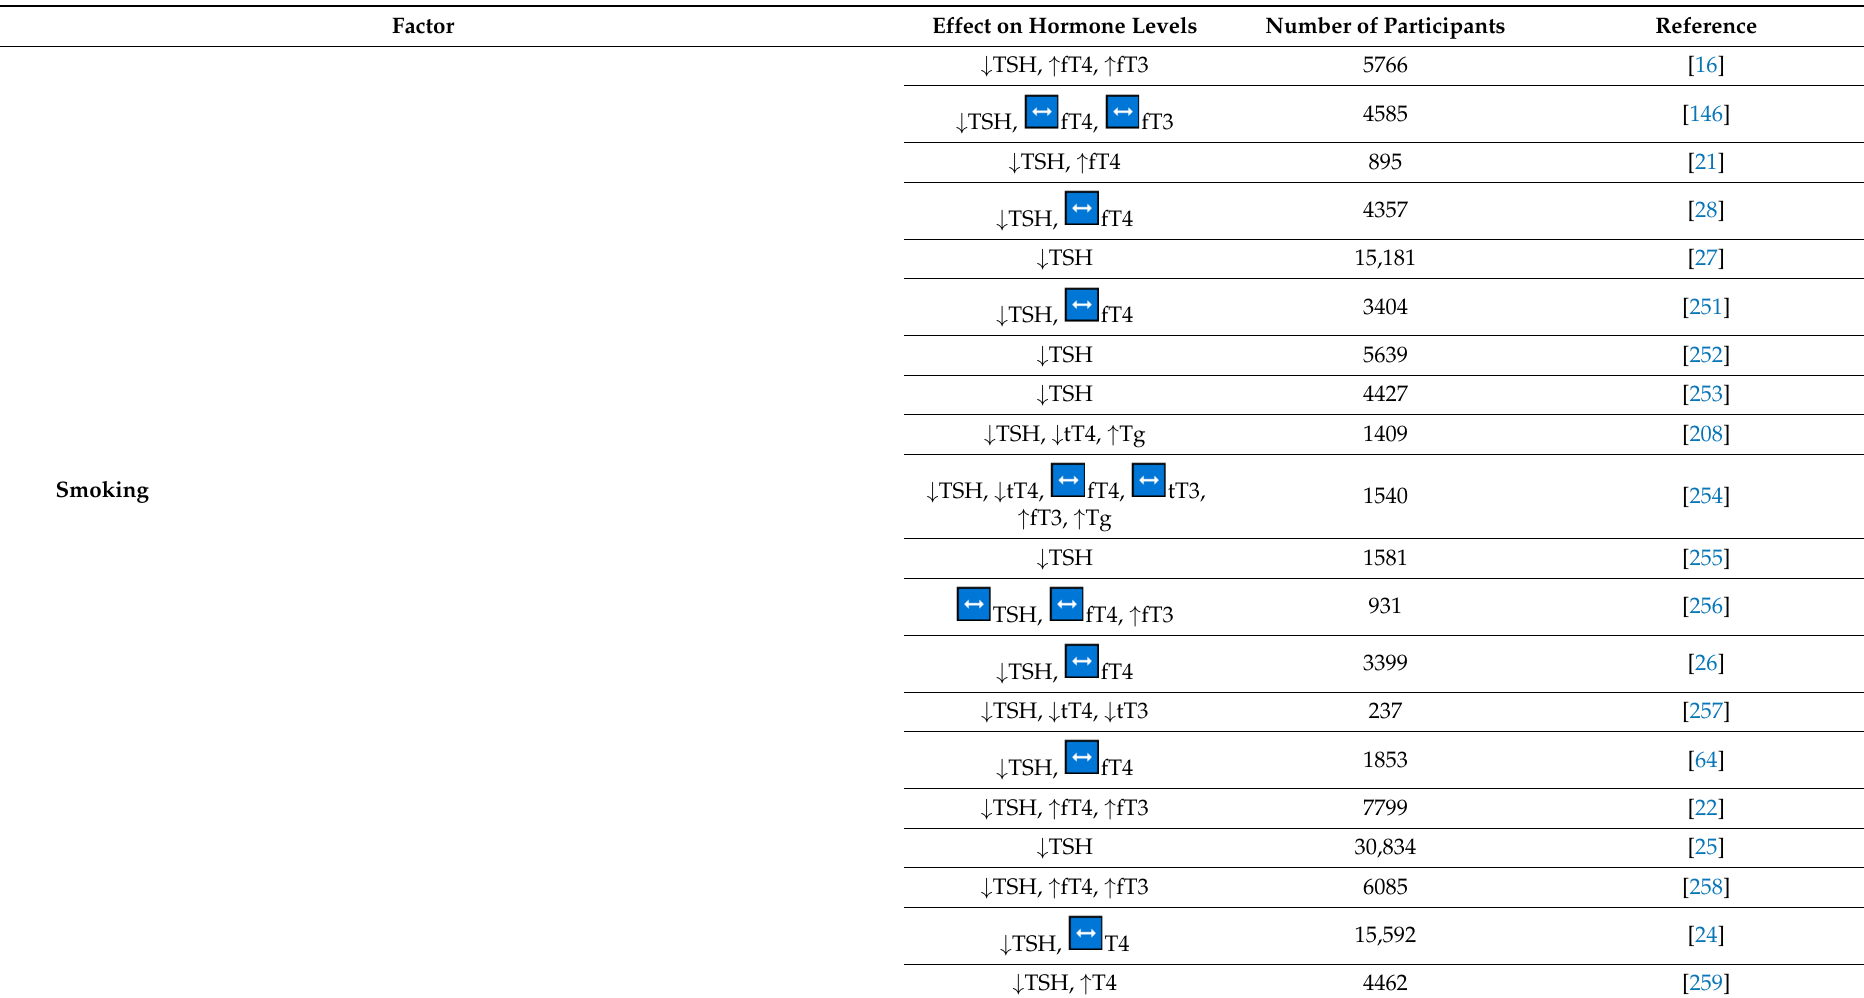
Table 1. Effect of lifestyle factors on thyroid-stimulating hormone, thyroid hormone and thyroglobulin levels in healthy individuals.